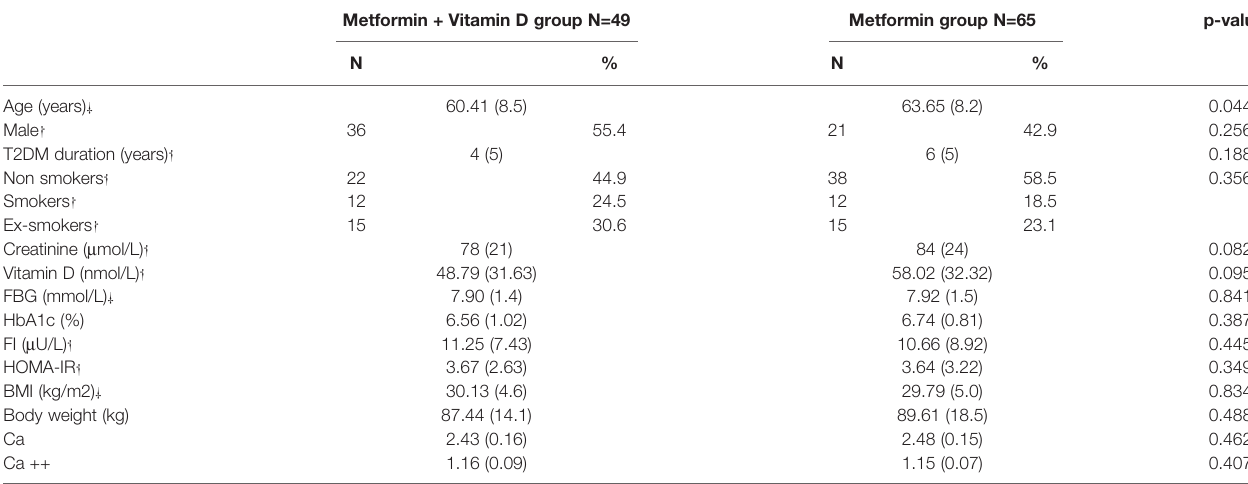
TABLE 1 | Baseline demographic characteristics of study population.